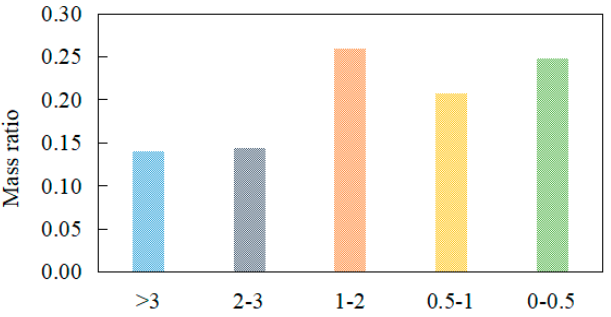
Table 1. The physical and chemical properties of coking coal [23].